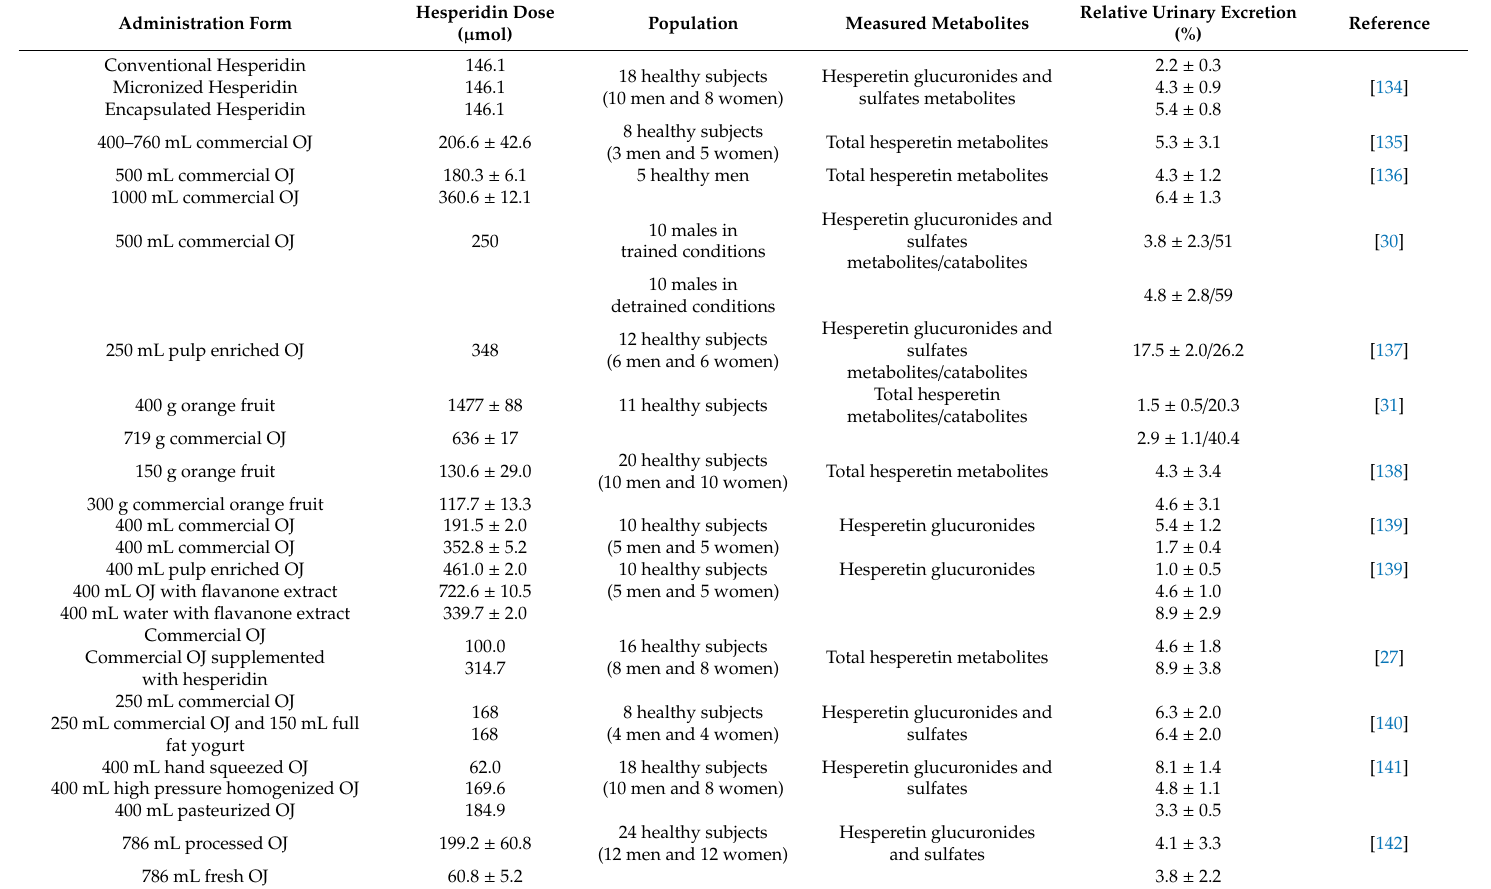
Table 1. Hesperidin bioavailability expressed as percent urinary excretion in human intervention